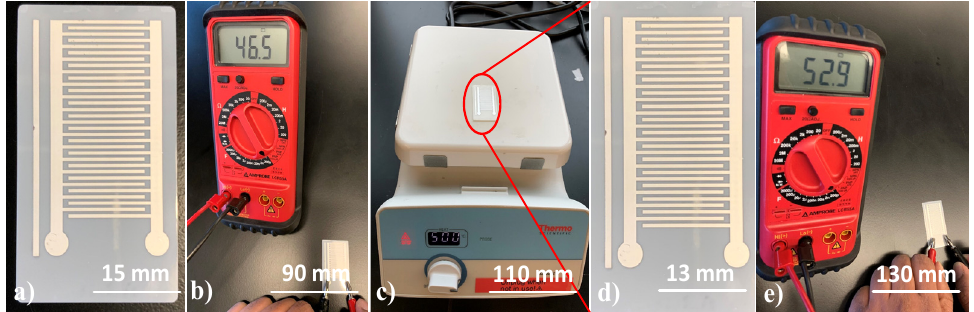
Figure 10. High-temperature stability test results ( a ) Interdigitated capacitive pattern after sintering, ( b ) Measuring capacitance using LCR meter, ( c ) Heating on the hotplate at 500 °C, ( d ) Capacitive pattern after one-hour heating, and ( e ) Measuring capacitance using LCR meter after heating.